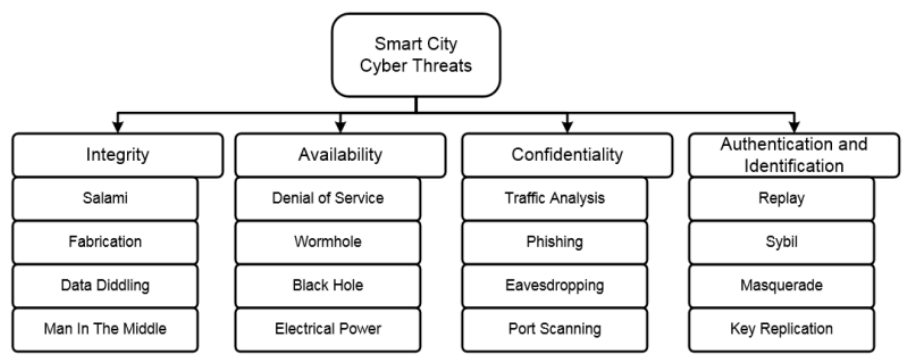
Figure 2. A common classification for the cyber threats of smart city infrastructure [47]. Alibasic et al. [52] explained the main concepts of smart cities and their components. They also reviewed different cybersecurity threats and challenges and proposed